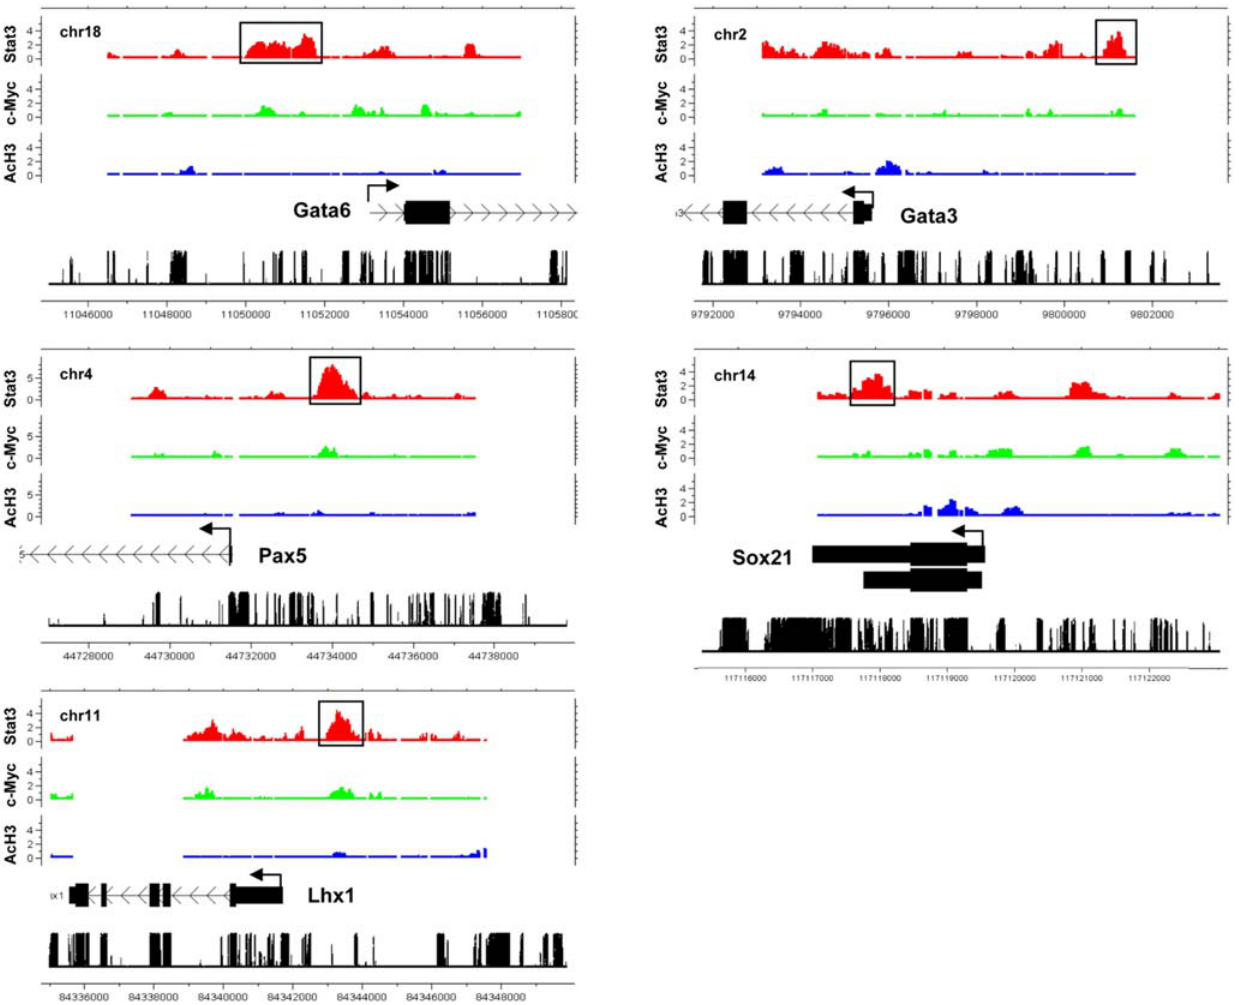
Figure 5. Stat3 binds developmentally repressed genes in ES cells. Genome-wide analysis of Stat3 and c-Myc TF binding sites and histone H3 acetylation (AcH3) at developmentally repressed genes (Gata6, Gata3, Pax5, Sox21, and Lhx1). Moving average (MA) enrichment values adjusted to log2 are shown. Chromosome number, sequence position, and conservation are also indicated on the plot.